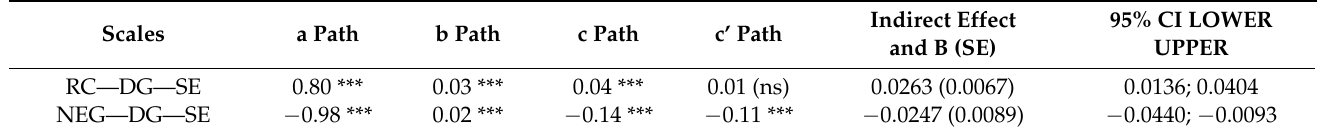
Table 3. Role of Dispositional gratitude in the relationship between Religious comfort/Negative emotions toward God and Self-Esteem ( N =